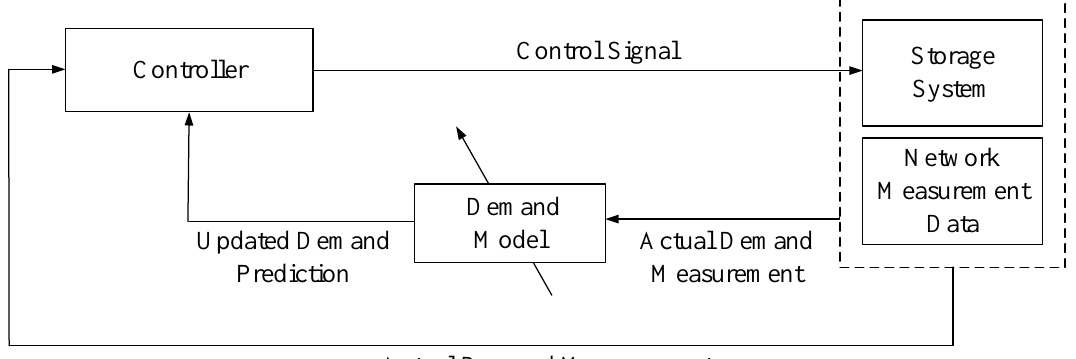
Figure 2. The model predictive control